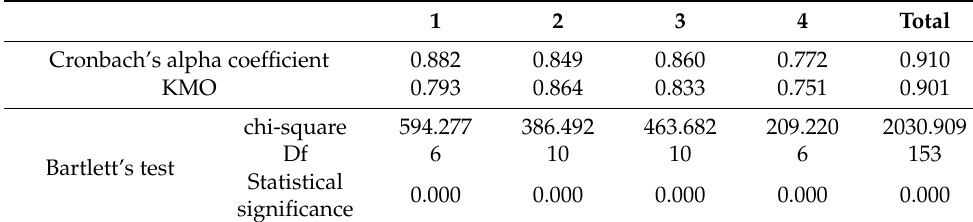
Table 2. Reliability, KMO, and Bartlett test of sphericity.